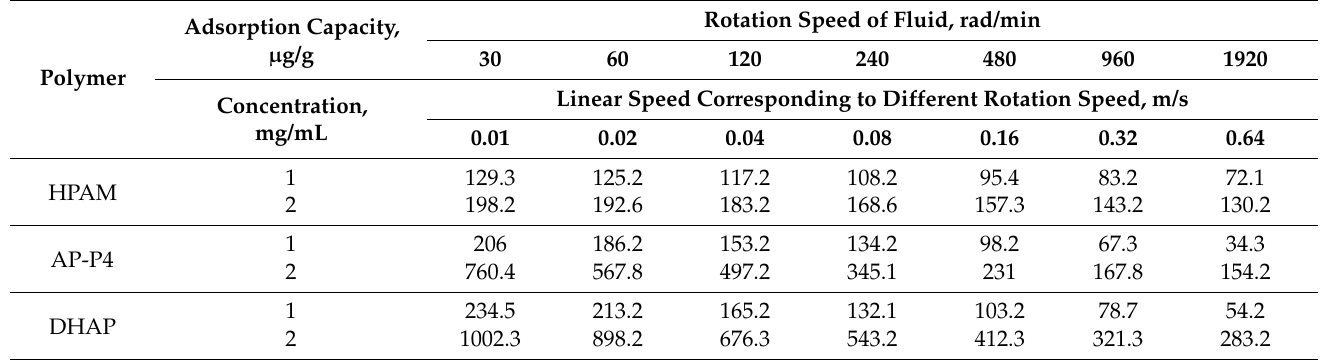
Table 6. Effect of movement speed on polymer adsorption capacity.